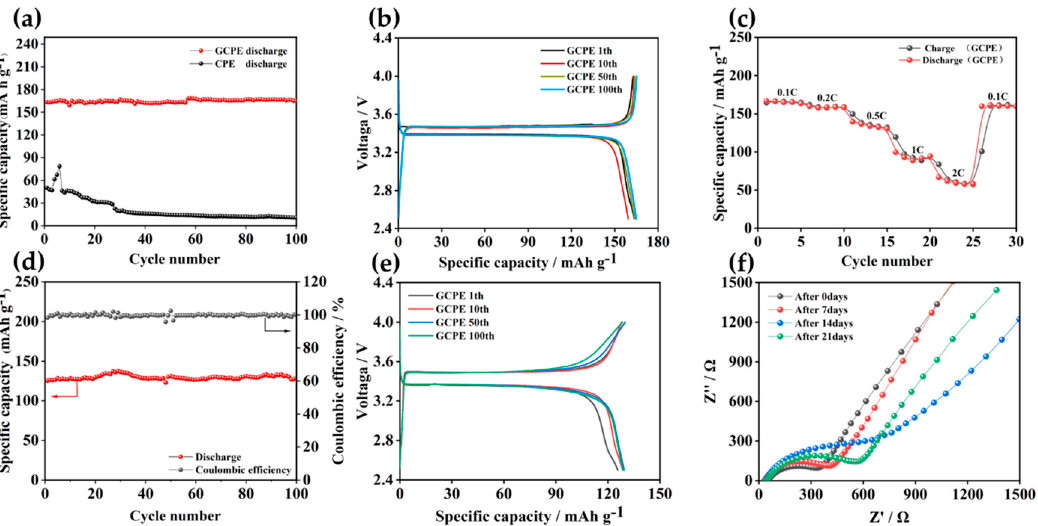
Figure 6. ( a ) Cycling performance of LFP/CPE/Li cells and LFP/GCPE/Li cells at room temperature. ( b ) Charge/discharge profiles of LFP/GCPE/Li at room temperature. ( c ) Rate capability of LFP/GCPE/Li at room temperature. ( d ) Cycling performance of LFP/GCPE/Li at 0 °C. ( e ) Charge/di − charge profiles of LFP/GCPE/Li at 0 °C. ( f ) The EIS of LFP/GCPE/Li battery for different aging time.